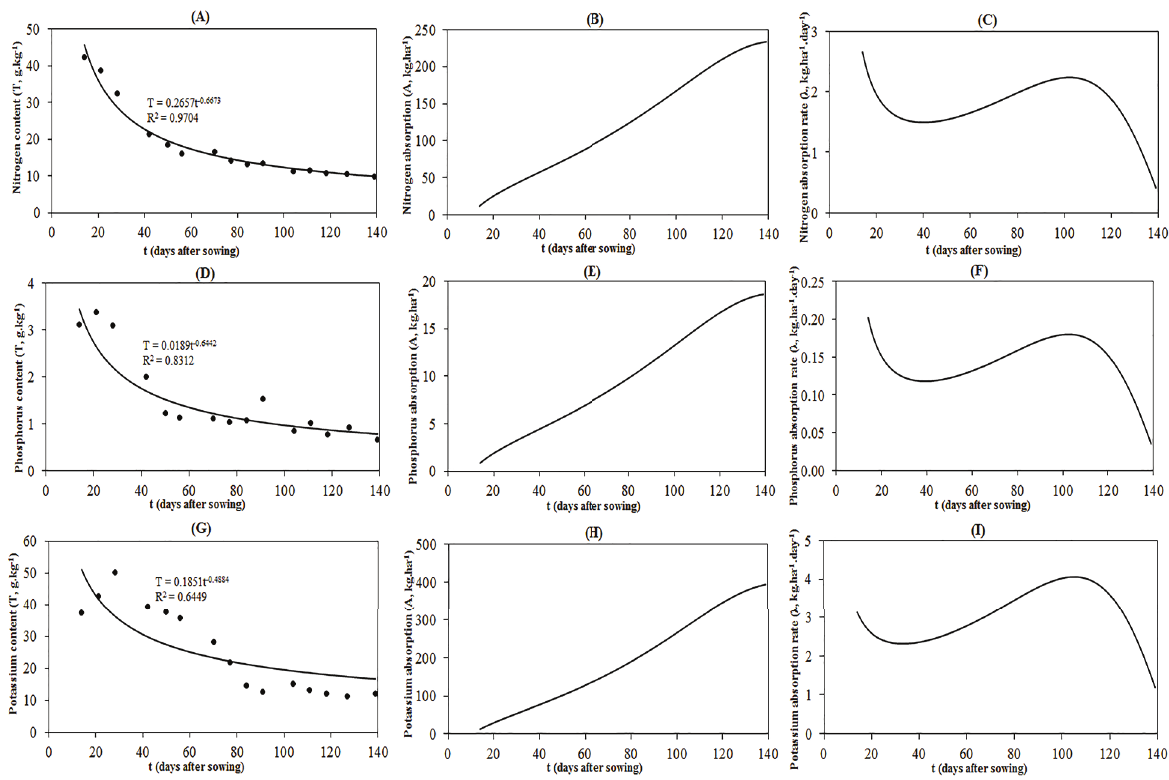
Figure 3 - Macronutrient content of the whole plant (T, g.kg -1 ), total absorption (A, kg.ha -1 ) and absorption rate (λ, kg.ha -1 .day -1 ) for nitrogen ( a , b and c ), phosphorus ( d , e and f ) and potassium ( g , h and i ) in the maize (hybrid DKB 390 PRO 2) crop (weighted average of all organs) in relation to the number days after sowing (t, days after sowing). Piracicaba (SP),